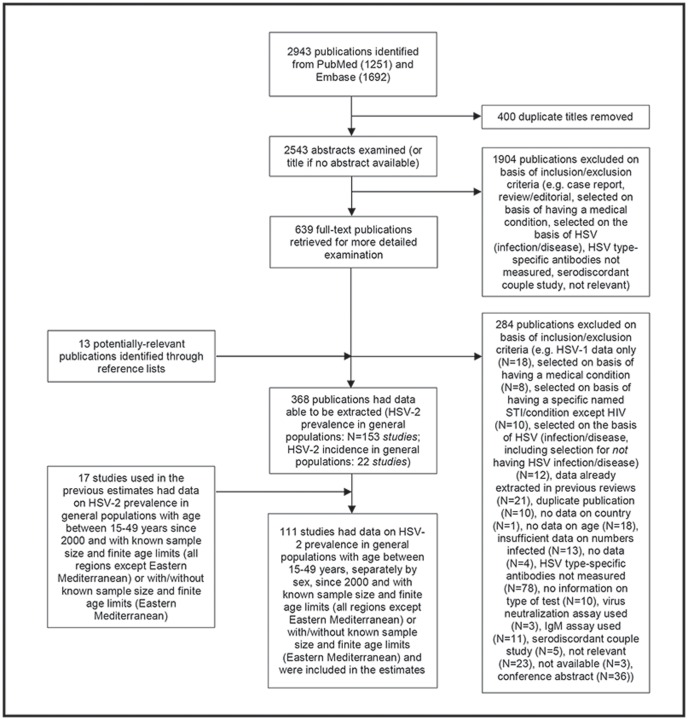
Flow chart showing selection of publications from the literature search.